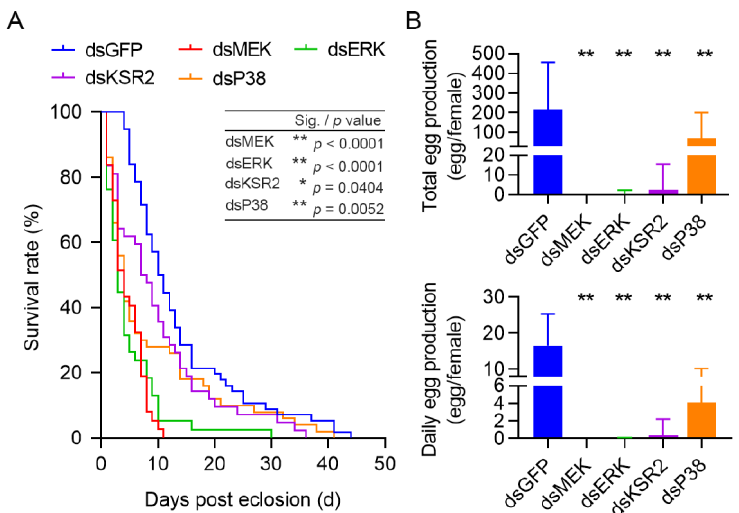
Figure 4. The survival rates and fecundity of silencing MEK , ERK , KSR2 , and P38 in female C. bowringi . ( A ) Survival curves of adult female beetles resulting from key gene silencing were generated using the KM survival estimate ( n = 37–56). The log-rank test was used to compare the significance of knocking down each key gene to the dsGFP control. ( B ) Total and daily egg production per female after dsRNA injection was measured throughout the adult stage of the cabbage beetles ( n = 17–56). All data were recorded daily and presented as mean ± SD. The significance of key gene treatments was determined using independent t -tests in comparison to the dsGFP control, * p < 0.05, ** p < 0.01.